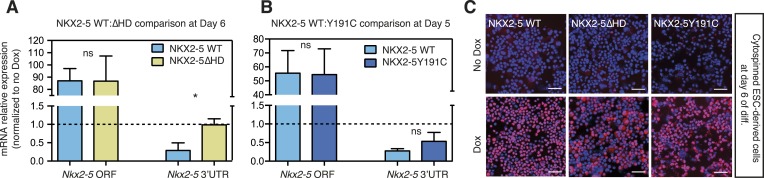
(A, B) RT-PCR quantification of Nkx2-5 ORF and endogenous Nkx2-5 (specifically detected using primers in the Nkx2-5 3′UTR, which is absent in the inducible construct) in NKX2-5 WT/Y191C/∆HD dox-inducible ES cell lines at day 6 (WT:∆HD comparison (A); 48 hr post-dox induction) and day 5 (WT:Y191C comparison (B); 24 hr post-induction).Results were normalised to expression in uninduced cells. p-values were calculated using a t-test (* p < 0.05; ns = not significant). (C) Detection of induced NKX2-5 WT, NKX2-5Y191C, and NKX2-5∆HD by immunofluorescence microscopy in cytospinned cells at Day 6 (48 hr post-dox induction). Scale bars represent 50 mm.